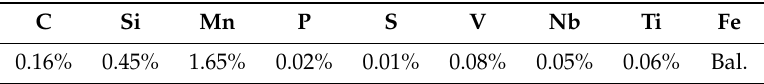
Figure 4. ( a ) Ferritic-Banitic microstructure of X65 pipeline steel by means of Optical Microscopy, ( b ) ( b ) Degenerated perlite islands and MAs micro / constituency within the crystalographyc and ( c ) grain Degenerated perlite islands and MAs micro/constituency within the crystalographyc and ( c ) grain orientaion mapping and averange grain size by EBSD analysis. orientaion mapping and averange grain size by EBSD analysis. Table 2. Chemical composition of X65 pipeline steel. Table 2. Chemical composition of X65 pipeline steel.